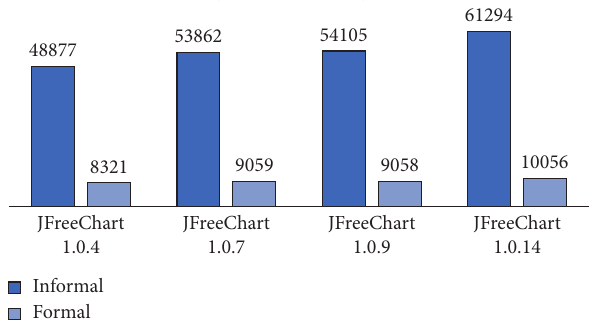
Figure 8: Count number of formal and informal relationships in JfreeChart.